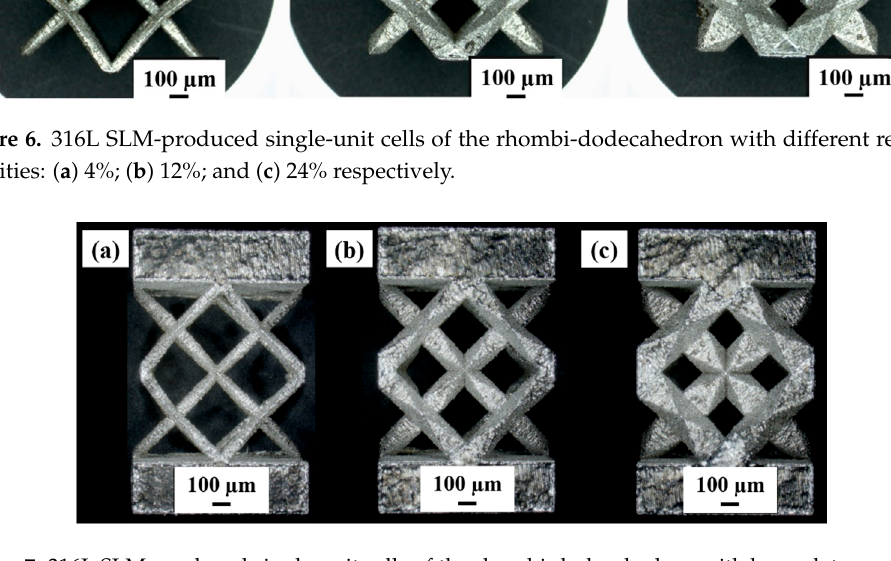
Figure 7. 316L SLM-produced single-unit cells of the rhombi-dodecahedron with base plates and with different relative densities: ( a ) 4%; ( b ) 12%, and ( c ) 24% respectively.